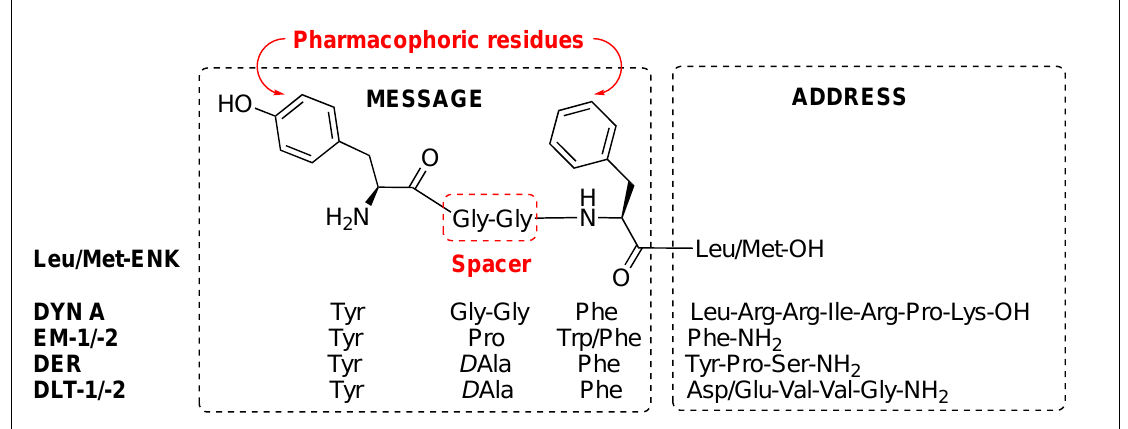
Figure 4. Message and address regions of natural opioid